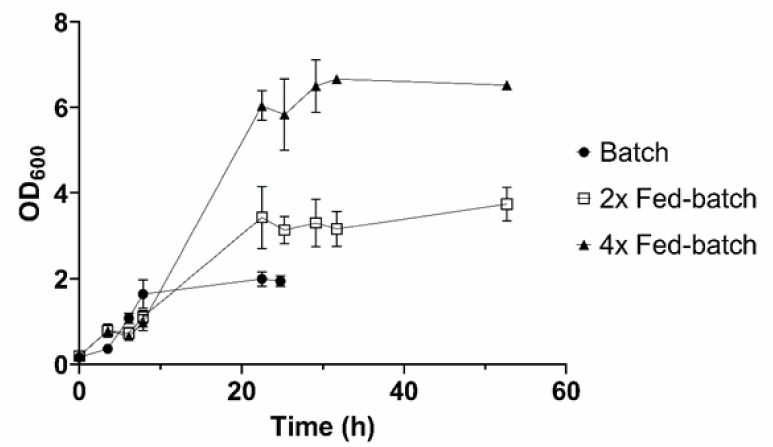
Figure 2. Fed batch cultivation of SOS3 in complex nutrient broth (NB) media. Data correspond to the average of two